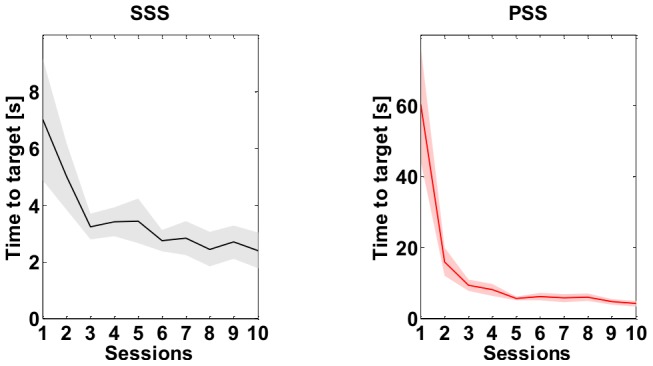
Task A: Time to Target (TT).Evolution of the TT index throughout the ten sessions of training. The continuous line is the mean value over the eight subjects while the shaded area corresponds to the standard error. Left panel refers to the SSS while right panel to the PSS one.